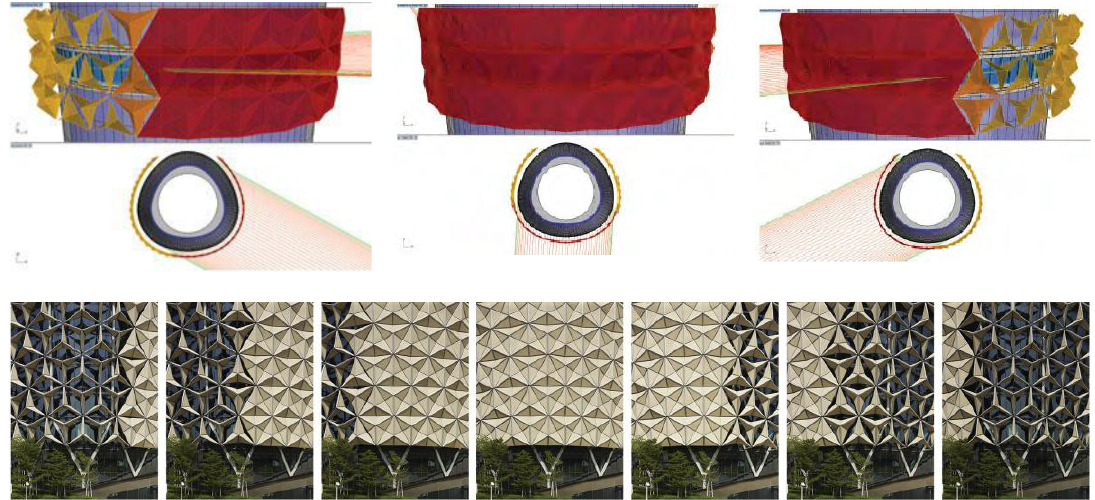
Figure 13. The Kinetic process of the shading system which track the sun location